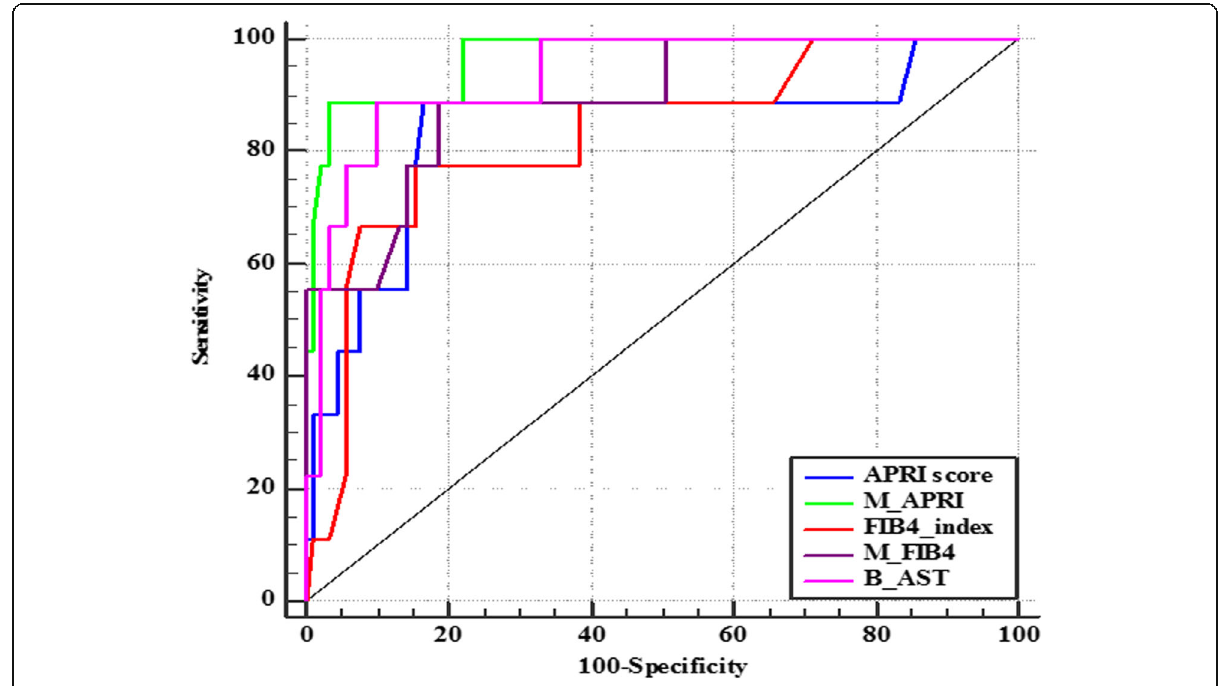
Fig. 2 Diagnostic performance (ROC curves) of the studied non-invasive biomarkers in the detection of advanced liver fibrosis (F3 –